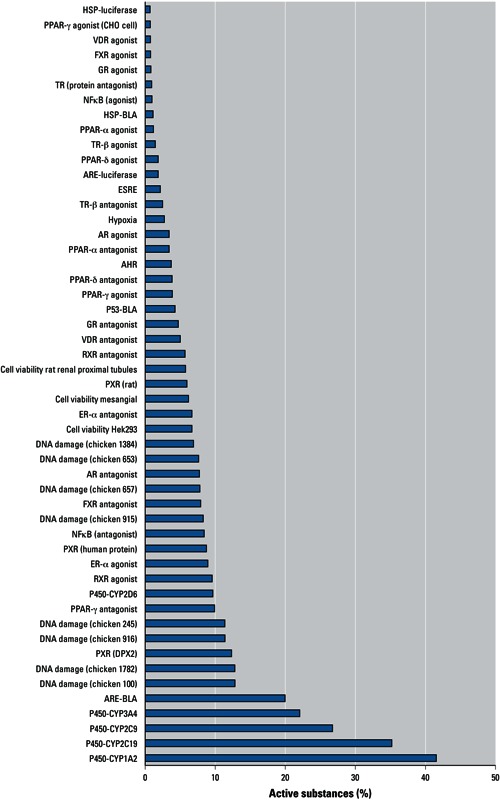
Results of nuclear receptor, DNA damage, cytochrome-p450, and miscellaneous assays of the NTP 1,408- and the U.S. EPA 1,462-compound libraries showing the percentage of substances classified as active in each assay. Abbreviations: AHR, aryl hydrocarbon receptor; AR, androgen receptor; ARE, antioxidant response element; ER, estrogen receptor; esrE, Escherichia coli strain K-12 substrain MG1655; FXR, farnesoid X receptor; GR, glucocorticoid receptor; HSP, heat shock protein; NFkB, nuclear factor-kB; PPAR, peroxisome proliferator-activated receptor; PXR, pregnane X receptor; RXR, retinoid X receptor; TR, thyroid hormone receptor; VDR, vitamin D receptor.